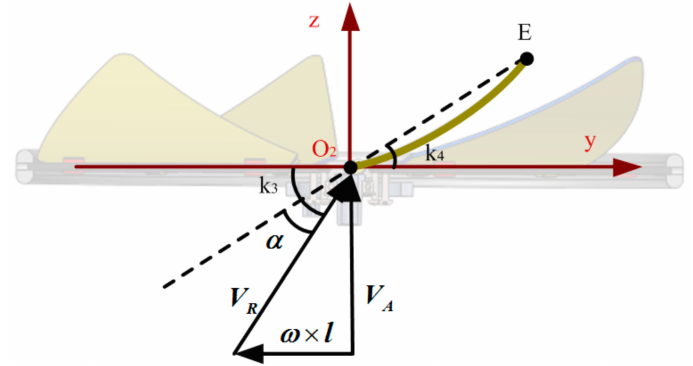
Figure 13. Relative impacting water flow and angle of attack of the